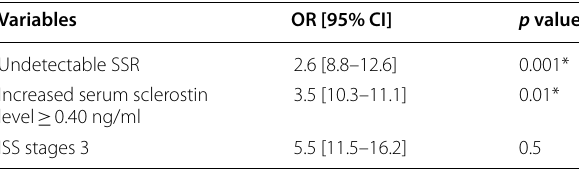
OR odds ratio, CI confidence interval, SSR sympathetic skin response, ISS International Staging System